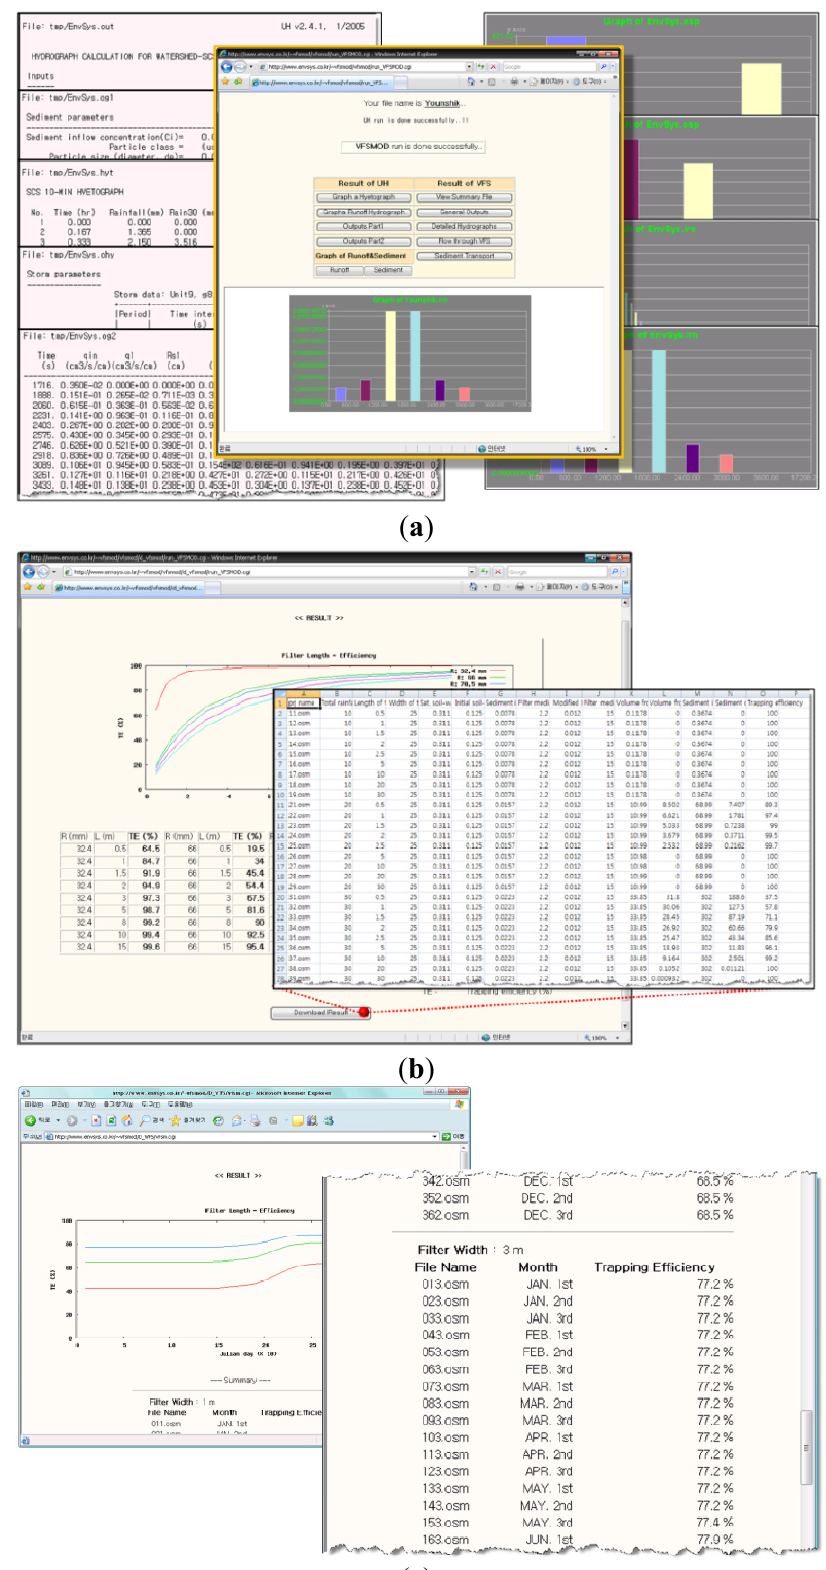
Figure 9. Tabular and graphical output of Web GIS-based VFSMOD system ( a ) Output interface of Single Storm Event Analysis (SSEA) module; ( b ) Output interface of Multiple Storm Event Analysis (SSEA) module; ( c ) Output interface of HUFF & SCS UH-based VFS design